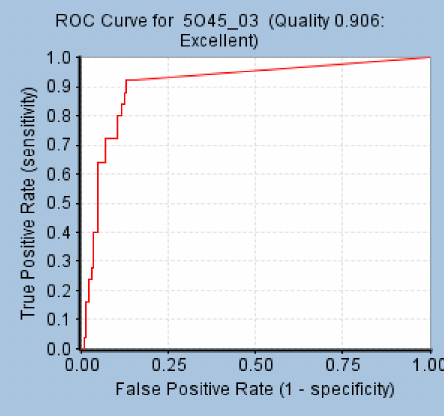
Figure 2. Receiver operating characteristics (ROC) curve of Hypo 1A.